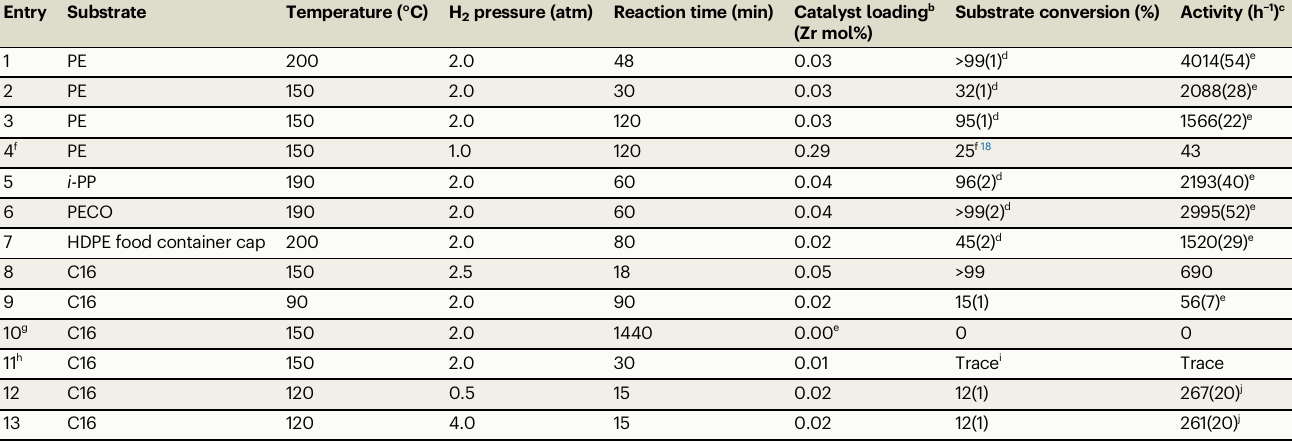
Table 1 | Polyole fi n and n -Hexadecane (C16) hydrogenolysis data over AlS/ZrNp 2 a